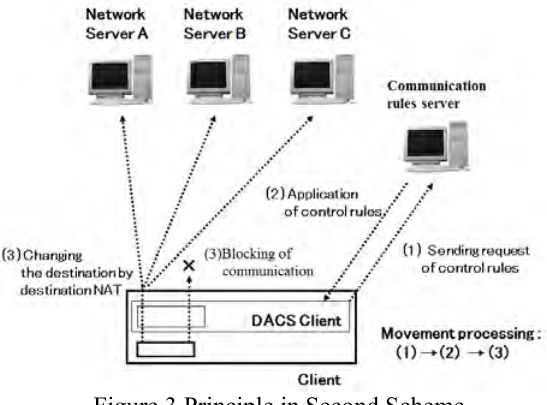
Figure 3 Principle in Second